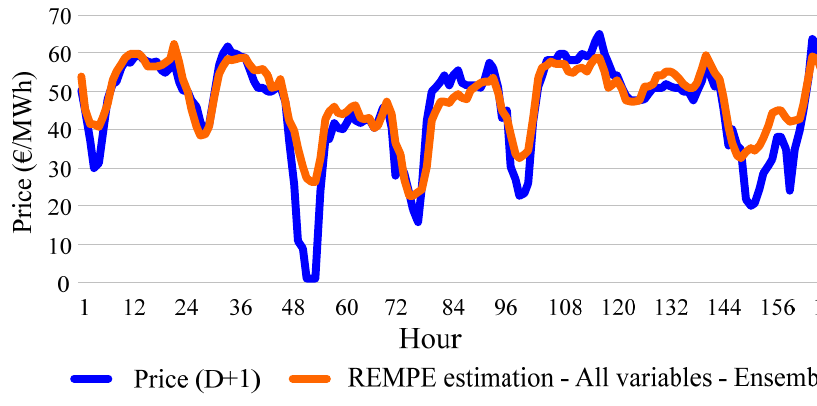
Figure 4. Actual prices and REMPE price estimation values for week 37 of 2013.